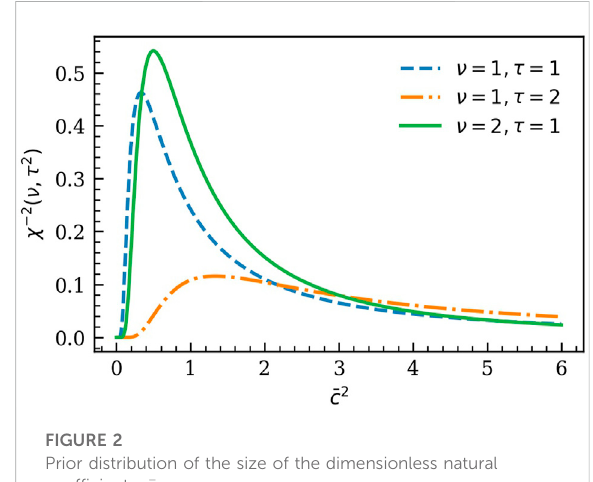
coef fi cients, (cid:2) c